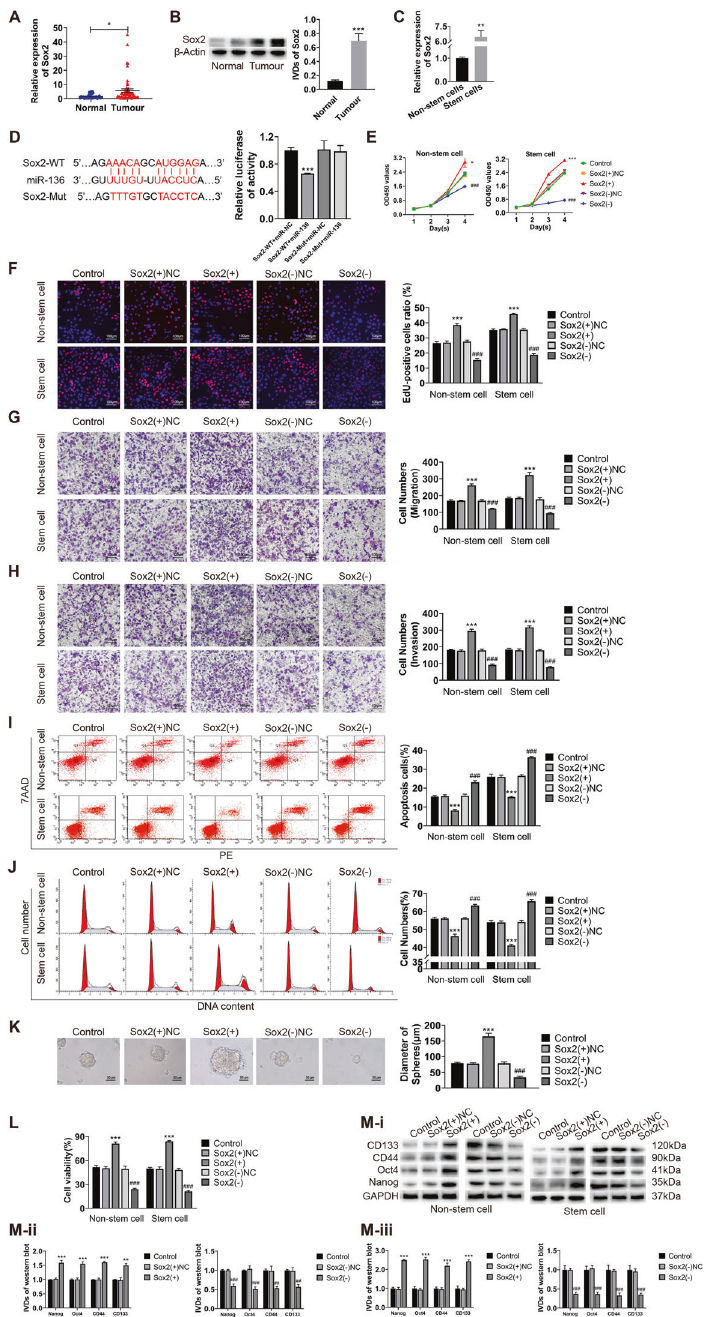
Fig. 4 Sox2 is highly expressed in endometrial cancer and promote malignant behavior of ECCs and ECSCs by participating in PVT1/miR- 136 regulation. A , B Sox2 expression was evaluated in endometrial cancer tissues ( n = 55) and normal endometrial tissues ( n = 30) by qRT- PCR and western blot. C Sox2 expression was evaluated in endometrial cancer non-stem cells and stem cells by qRT-PCR. D The targeted binding site of Sox2 and miR-36 was validated by dual-luciferase reporter assays. Data are presented as the means ± SD ( n = 3, each group), * P < 0.05, ** P < 0.01, *** P < 0.0001 vs. control group. E , F Effects of Sox2 on proliferation in endometrial cancer non-stem cells and stem cells evaluated by CCK8 and EdU assays. G Effects of Sox2 on cell migration in endometrial cancer non-stem cells and stem cells evaluated by transwell assays. H Effects of Sox2 on cell invasion in endometrial cancer non-stem cells and stem cells evaluated by transwell assays. I Effects of Sox2 on cell apoptosis in endometrial cancer non-stem cells and stem cells evaluated by fl ow cytometry. J Effects of Sox2 on the cell cycle (G0/G1 phase) in endometrial cancer non-stem cells and stem cells evaluated by fl ow cytometry. K Effects of Sox2 on cell self-renewal capacity in ECSCs evaluated by sphere formation assays. L Effects of Sox2 on resistance of CBP in endometrial cancer non-stem cells and stem cells evaluated by CCK8. M Effects of Sox2 on stemness markers (CD133, CD44, Oct4, and Nanog) in endometrial cancer non-stem cells and stem cells evaluated by western blot. Data are presented as the means ± SD ( n = 3, each group), * P < 0.05, ** P < 0.01, *** P < 0.0001 vs. Sox2( + )NC group; # P < 0.05, ## P < 0.01 and ### P < 0.001 vs. Sox2(-)NC